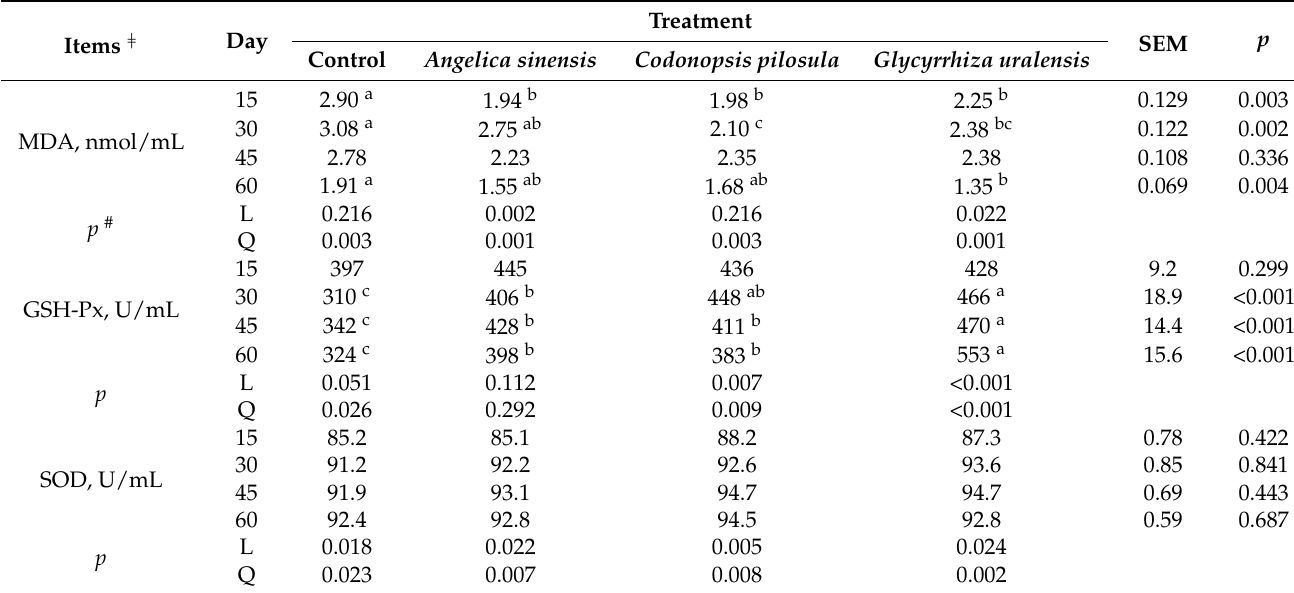
Table 3. Serum antioxidant capacities of early weaned yak calves consuming different herbal extract